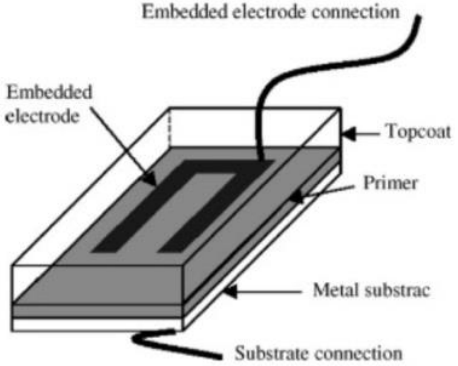
Figure 13. An illustration of electrodes embedded in Pt coating for ENM measurement. Reprinted with permission from ref. [95]. Elsevier, 2008.